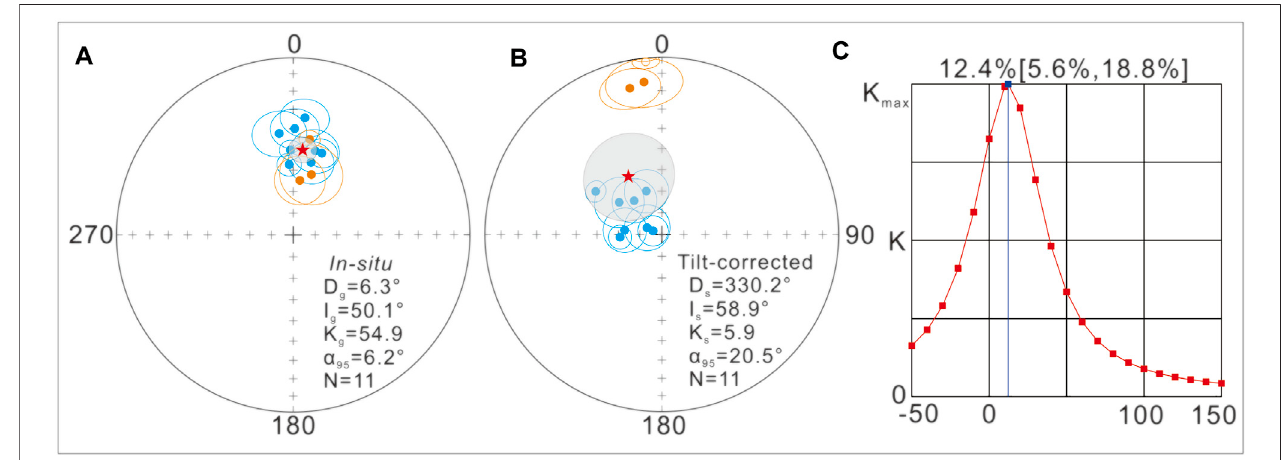
FIGURE 9 | Equal-area projections of the characteristic remnant magnetization directions and their Watson and Enkin (1993) progressive unfolding analysis (C) of the Upper limestone ZD Formation (A) in situ (B) tilt-corrected. Open/solid circles represent upward/downward inclinations in a and b; blue/orange symbols represent sites from the south/north limb in a and